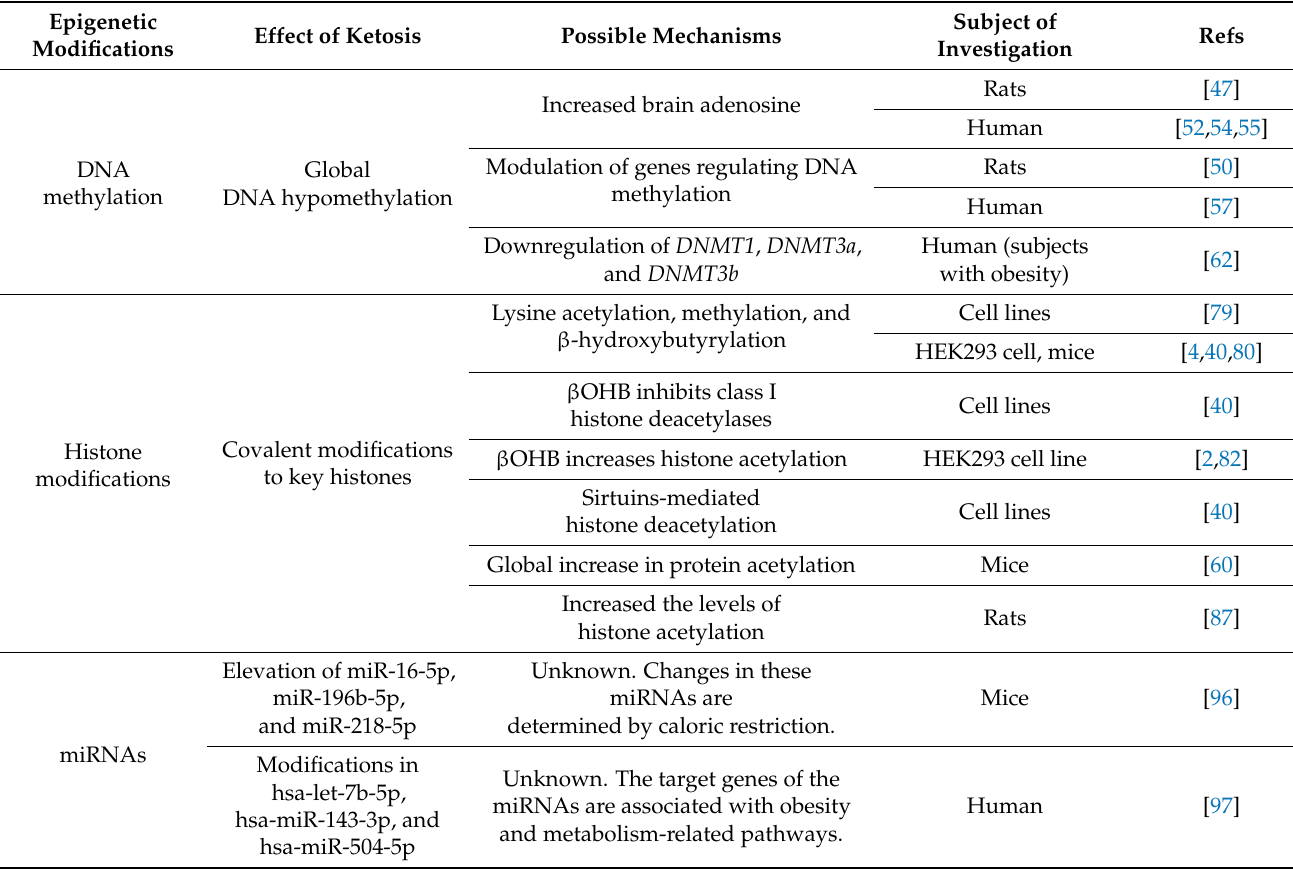
Table 1. Epigenetic changes determined by